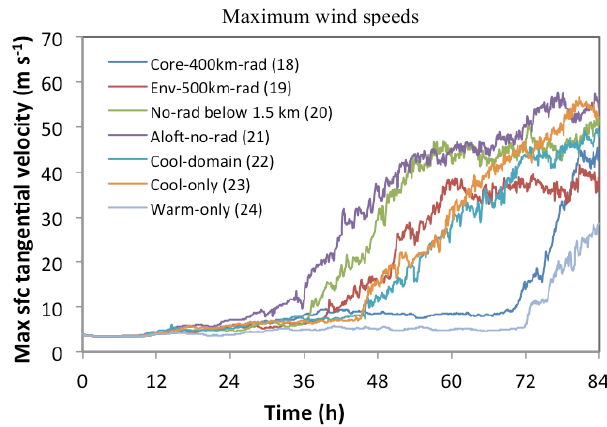
Figure 25. Time series of maximum azimuthally averaged tangen- tial wind speeds at z = 29 . 5m (ms − 1 ), for Experiments